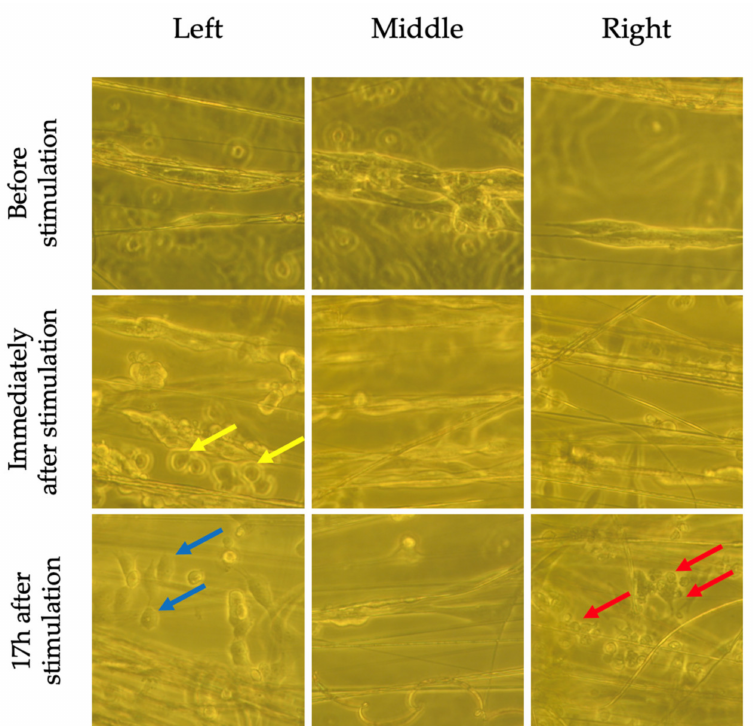
Figure 9. Bright field images of stimulated SH-SY5Y cells on aligned fibers before, immediately following and 17 h after ES. Cells near the electrodes (left and right as per Figure 3) appear to have shortened (blue arrow), have begun detaching (yellow arrow), and some appear dead (red arrow). The cells in the middle do not appear to be